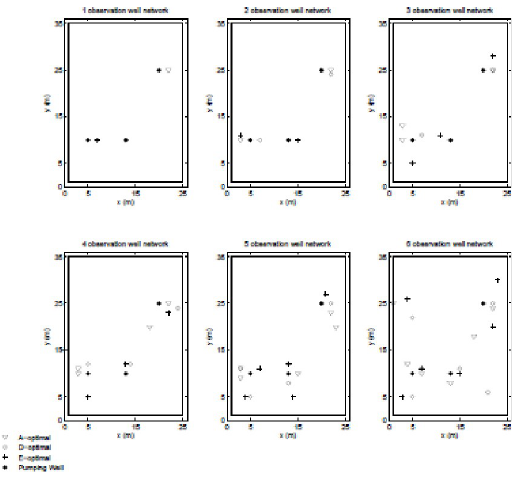
Fig 4. A-, D-, and E-optimal